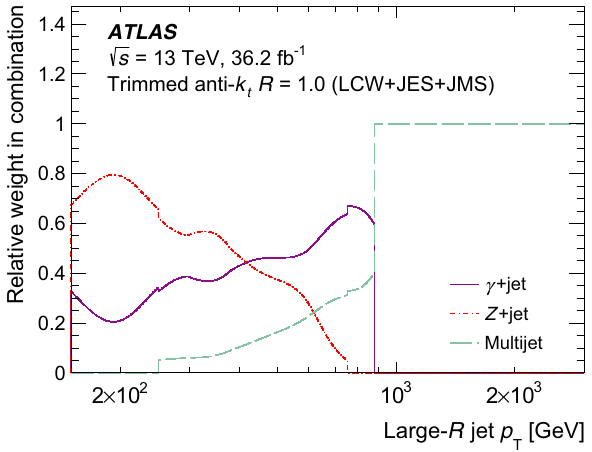
Fig. 26 Theweightassignedtodifferenttechniquesinthecombination of in situ measurements of the relative p T response of large- R jets in data and simulations, as a function of the jet transverse momentum p T . For each p T bin, the weight of the Z +jet, γ +jet, and multijet balance methods are shown. The slight discontinuities observed in the weights correspondtotheonsetofthemultijetbalancemethodat p T ∼ 300GeV and to the upper end of the Z +jets method for p T ∼ 800 GeV